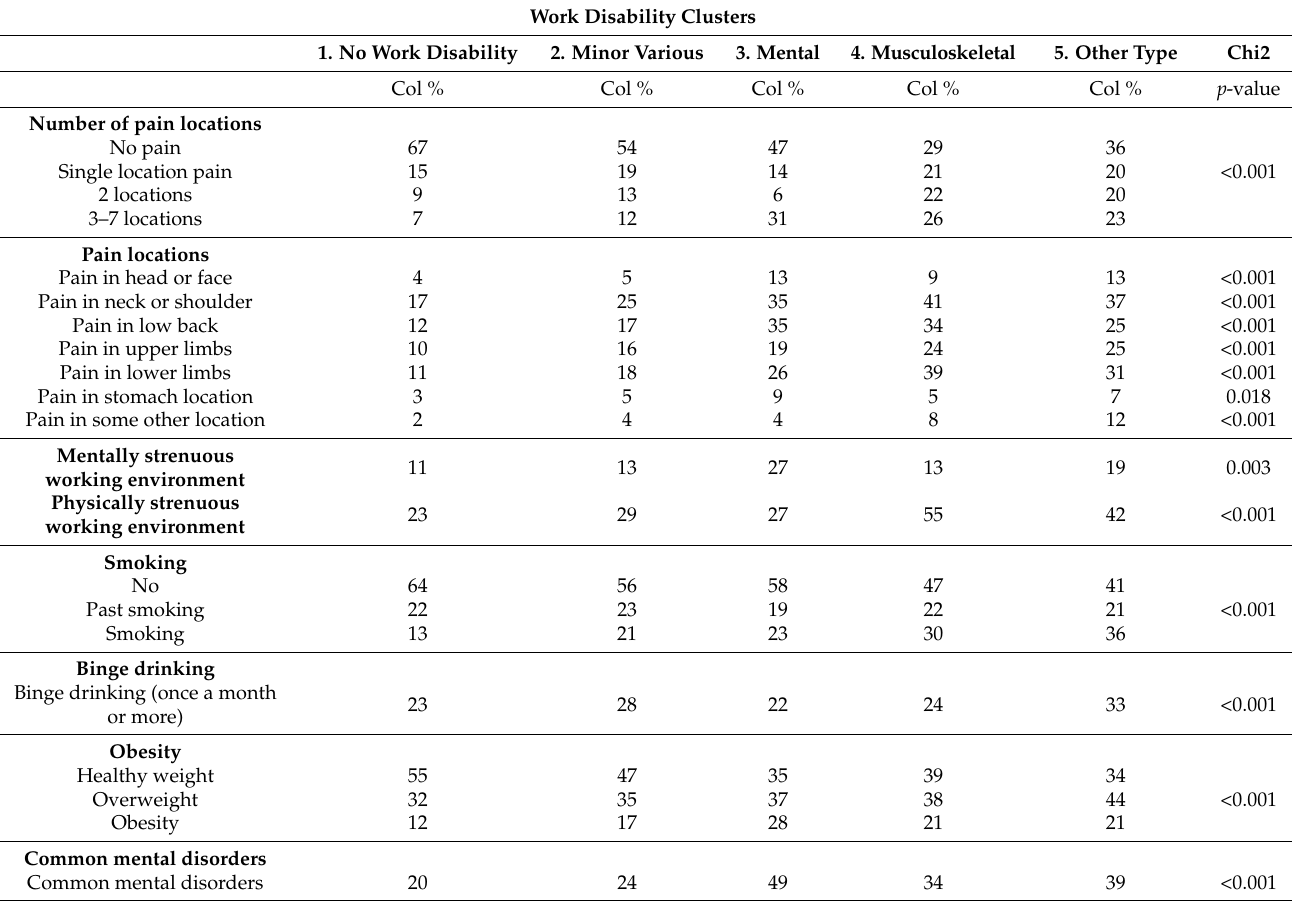
Table 2. Work disability clusters, pain and modifiable working and lifestyle factors. Work Disability